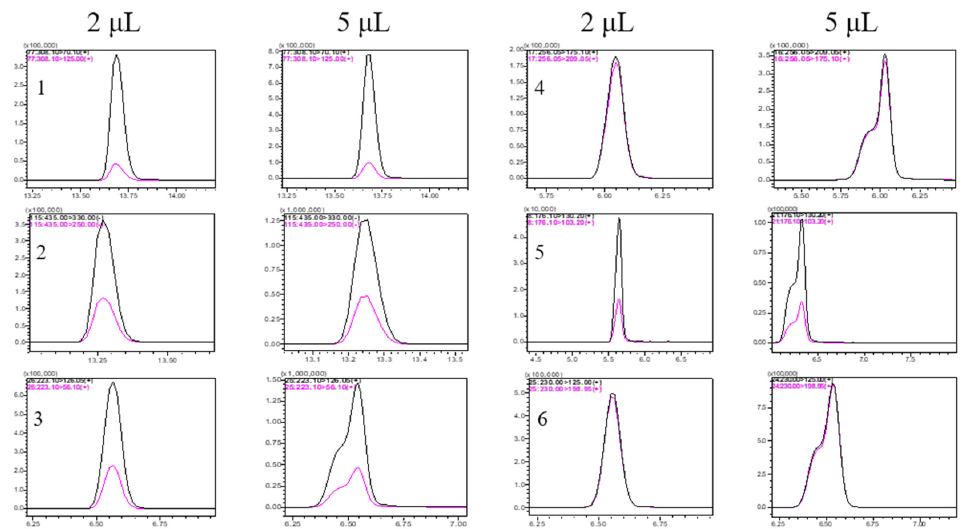
Figure 1. Chromatograms of six representative pesticides (Tebuconazole (1), Fipronil (2), Acetamiprid (3), Imidacloprid (4), 3-Indoleacetic Acid (5), Dimethoate (6); injection volume: 2 and 5 μ L.